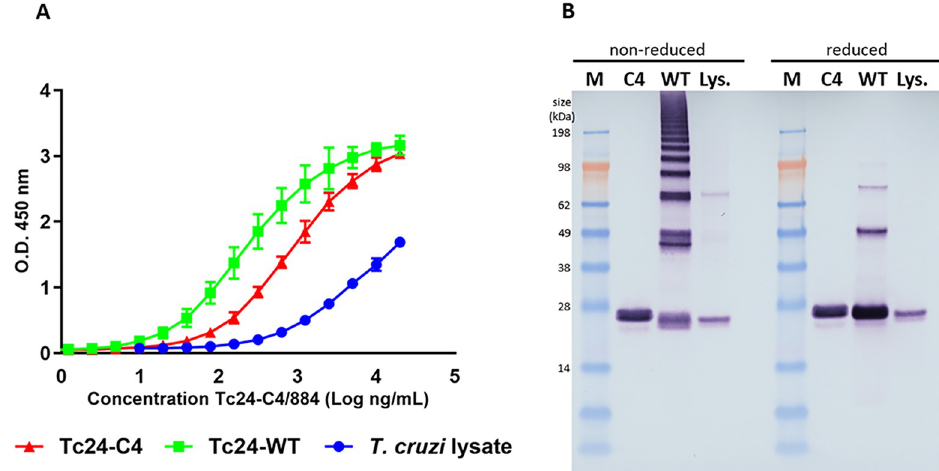
Fig 1. mAb Tc24-C4/884 recognize Tc24-C4, Tc24-WT and native Tc24 in T . cruzi lysate in ELISA and Western blot. A) The binding of mAb Tc24-C4/884 to Tc24-C4 (red), Tc24-WT (green) and native Tc24 in T . cruzi WT: Tc24-WT, Lys.: T . cruzi trypomastigote